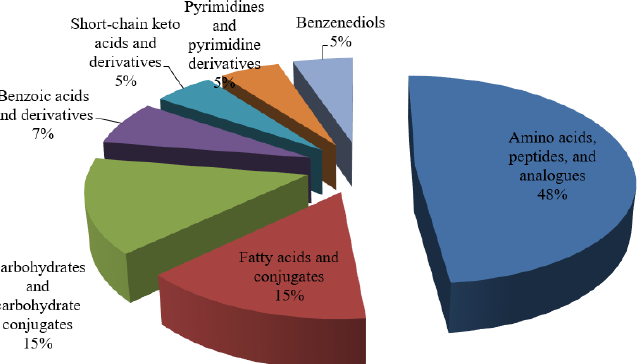
Figure 3. Metabolite full identification chemical structure subclass classification chart of L. fermen- tum RC4.